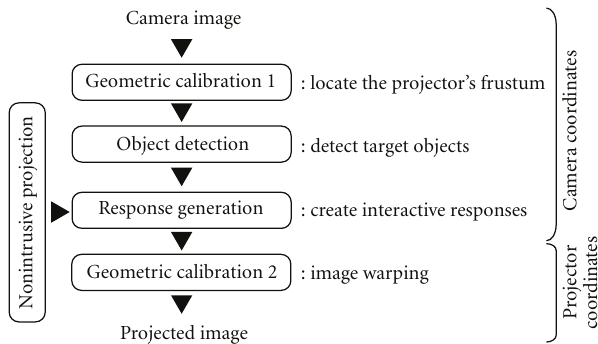
Figure 1: Procedural flow of the proposed framework during the online execution.